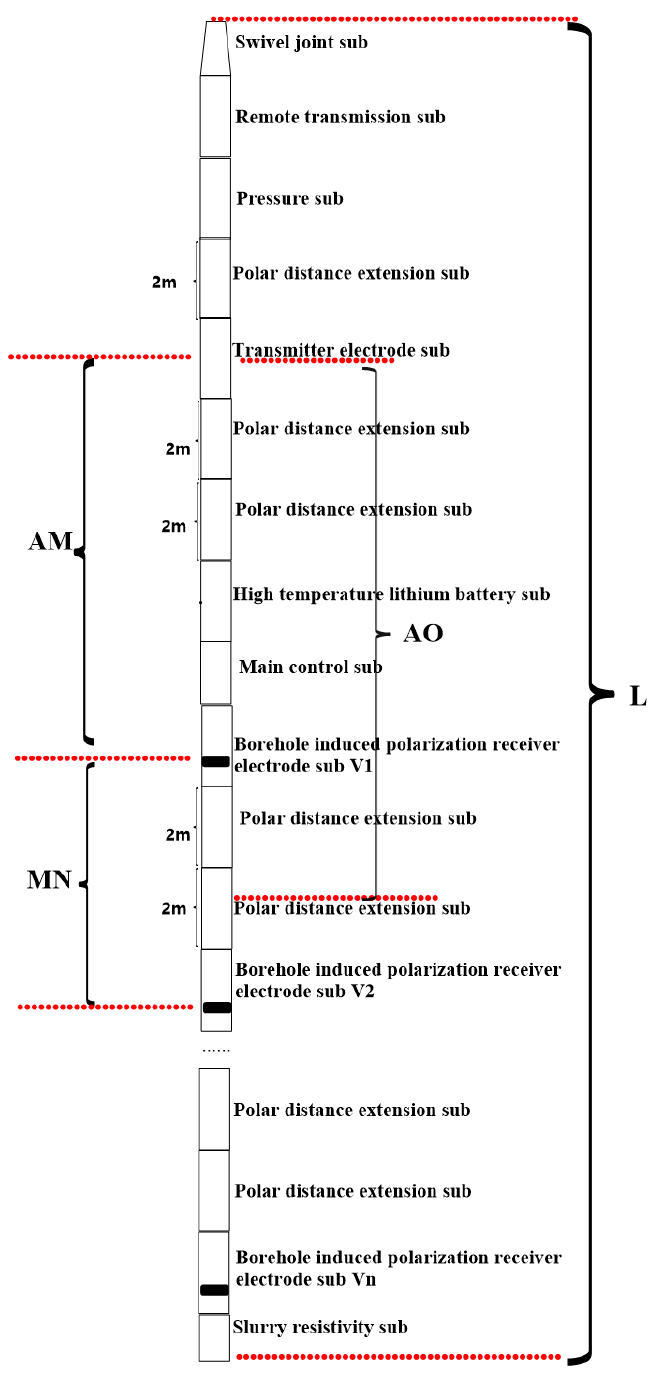
Figure 4. Structural diagram of the subs of the array receiver in the